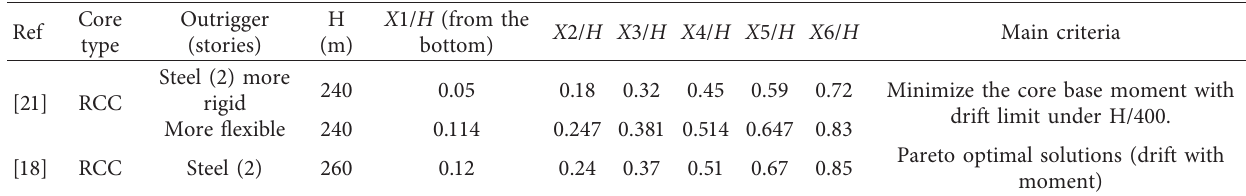
Table 10: Six outrigger structures.